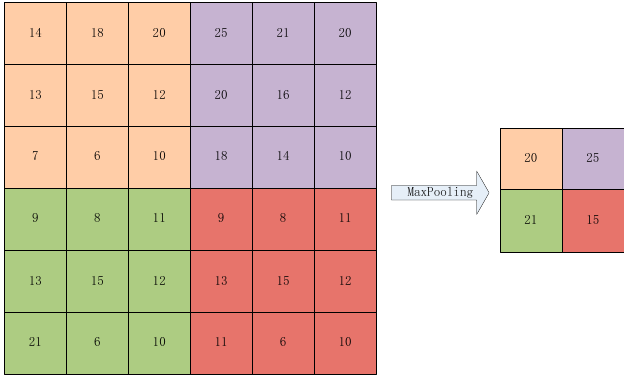
Figure 6. Pooling operation extracts the maximum value in each specified area. The size of the sliding window of the pooling operation is equal to the step size, so the scopes of each pooling result do not intersect.